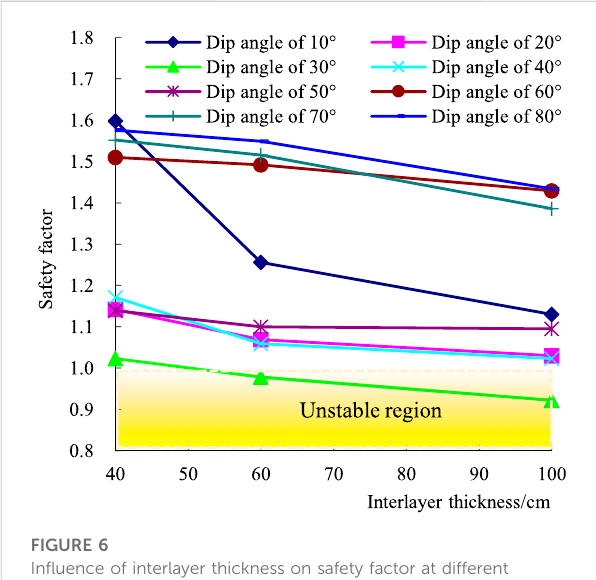
FIGURE 4 In fl uence of slope heights on safety factor at different interlayer angle.